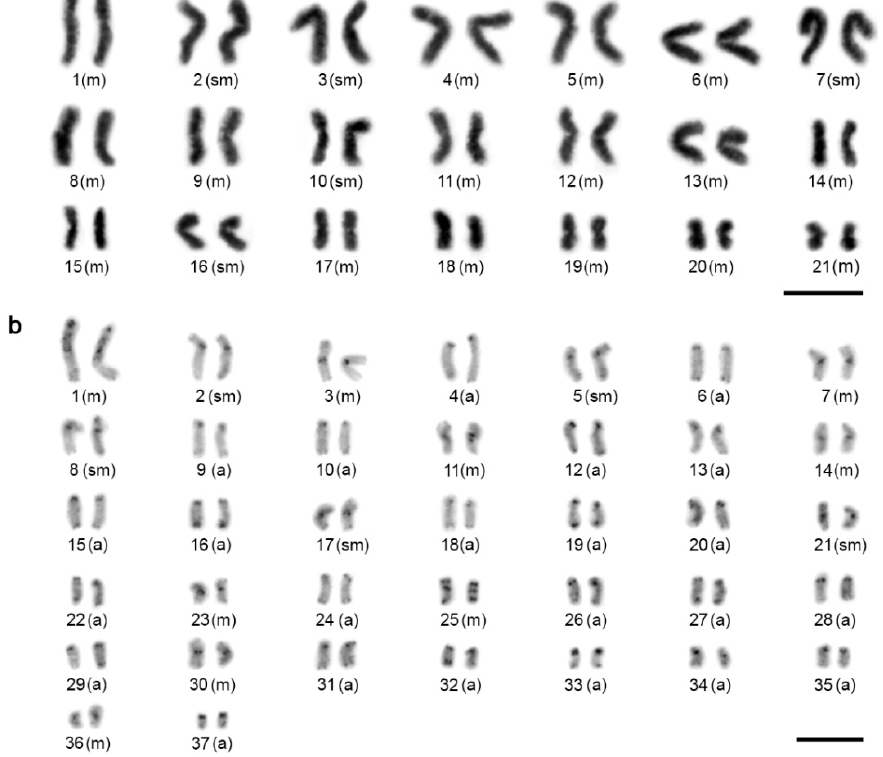
Figure 1. Male karyotypes of Charinus species I, constructed from mitotic metaphases. ( a ) C. dominicanus (Giemsa-stained, without banding) (2 n = 42). ( b ) C. pescotti (C-banding; chromosomes stained with DAPI, inverted picture) (2 n = 74). Abbreviations: m = metacentric chromosome, sm = submetacentric chromosome, st = subtelocentric chromosome, a = acrocentric chromosome. Scale bar = 10 µ m.